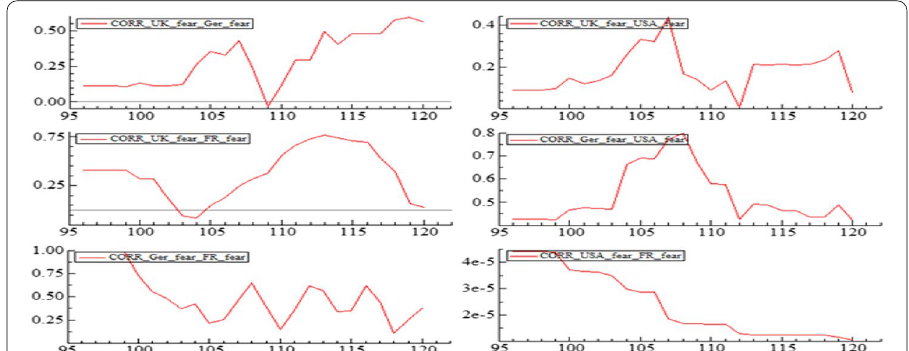
Fig. 3 Dynamic Conditional Correlations in European refugee’s crisis